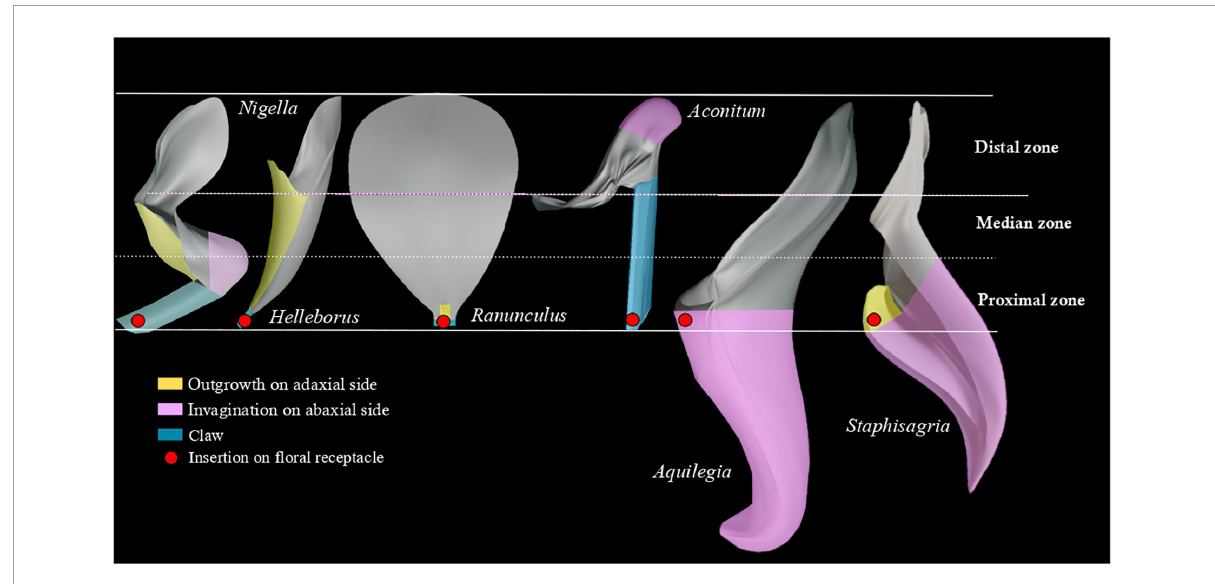
FIGURE2 Three-dimensional models of six petals summarizing the morphological diversity of Ranunculaceae petals. The petals are oriented in space according to their insertion on the floral receptacle, and divided in three equal zones: proximal, median, and distal. The red dot indicates the insertion on the floral